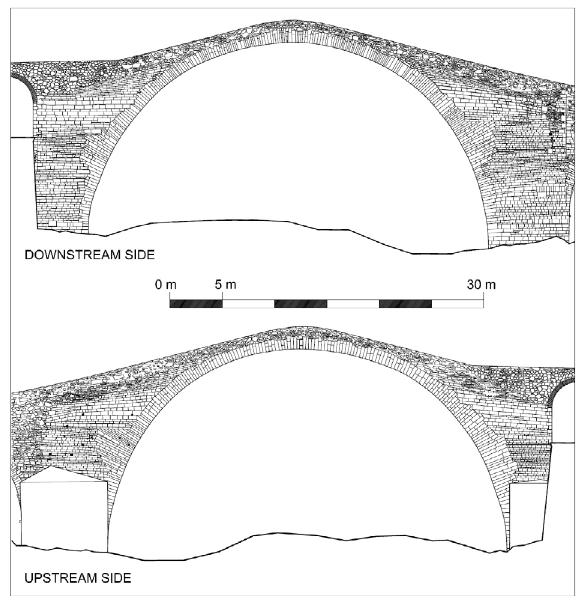
Figure 4. Masonry texture on the main arch from both down- stream and upstream sides.